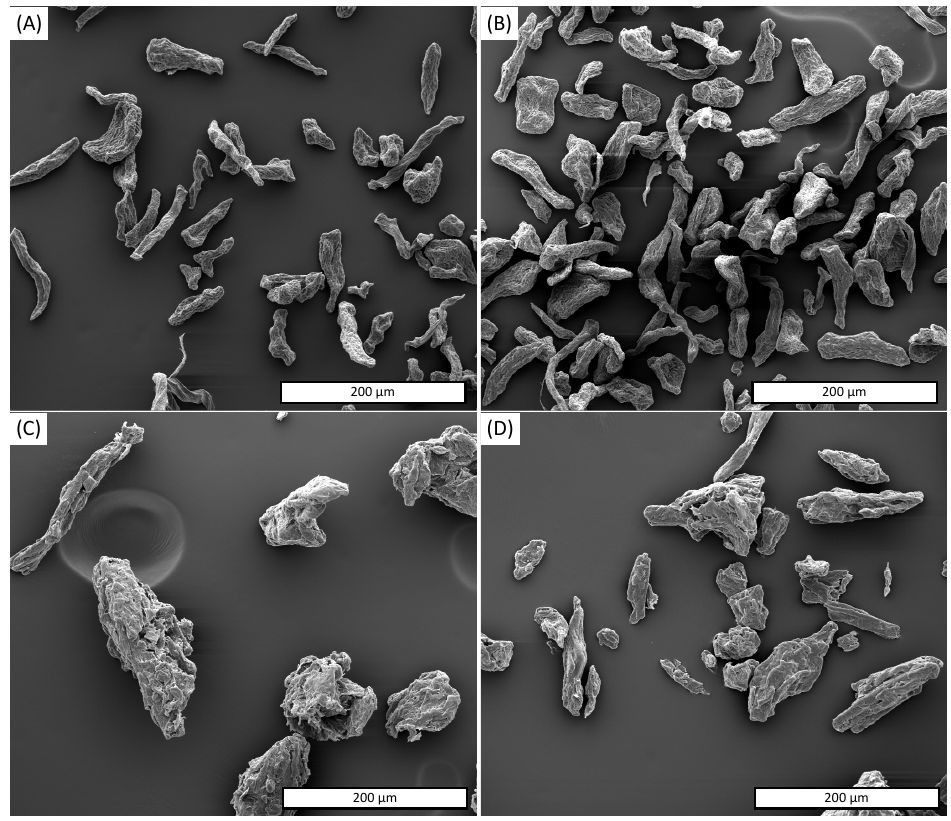
Figure 7. SEM images of MCC particles extracted from ( A ) PBAT/as-MCC 10%, ( B ) PBAT/as-MCC 20%, ( C ) PBAT/c-MCC 10%, ( D ) PBAT/c-MCC 20%.